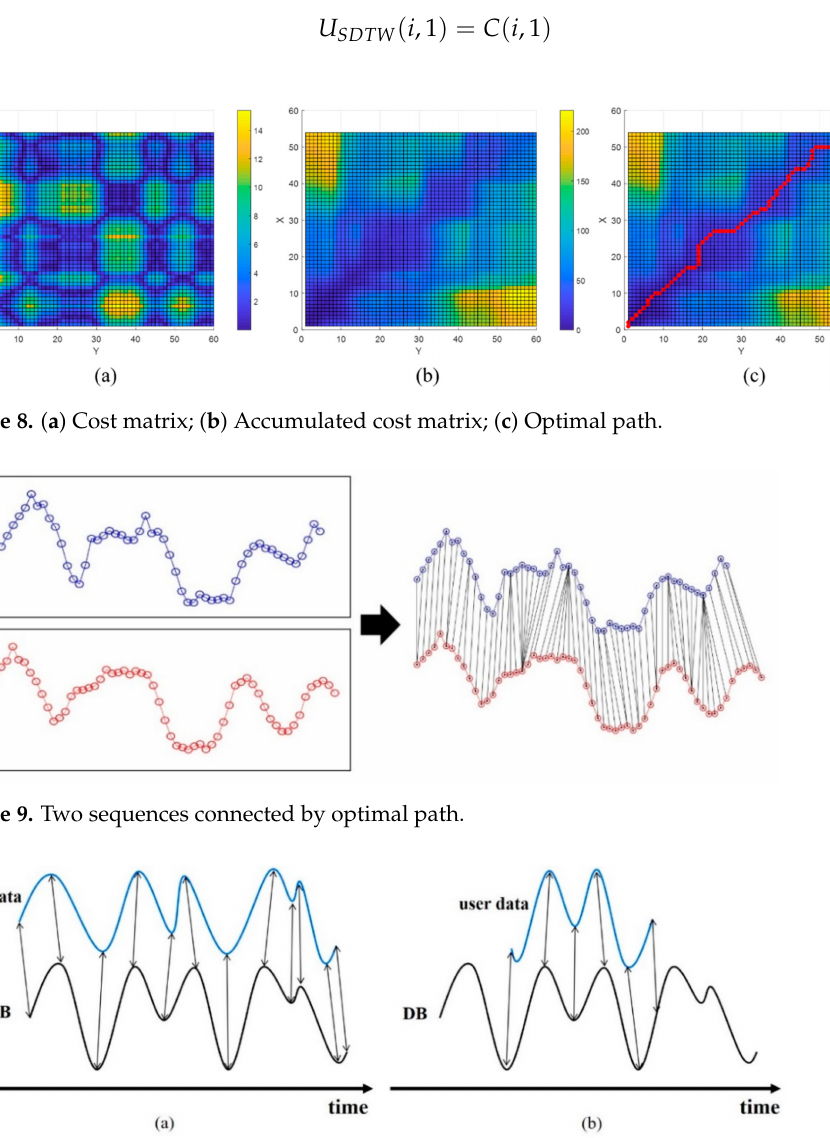
Figure 10. Comparison between DTW and SDTW. SDTW is applied when the physical length between sequences is different. ( a ) Aligned sequences using DTW; ( b ) Aligned sequences using SDTW. This indicates that the first row-element of U SDTW is always initialized, and the minimum element of the last row of U SDTW is the last pair of optimal paths in